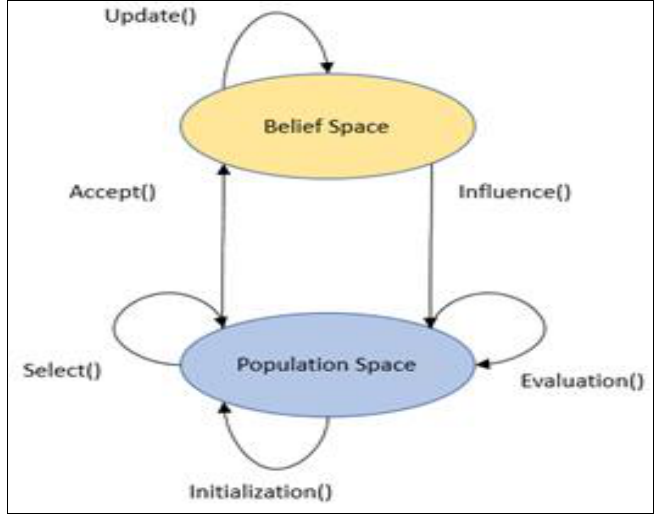
Figure 1: Structure of the Cultural Algorithm. Source: Adapted from [16].